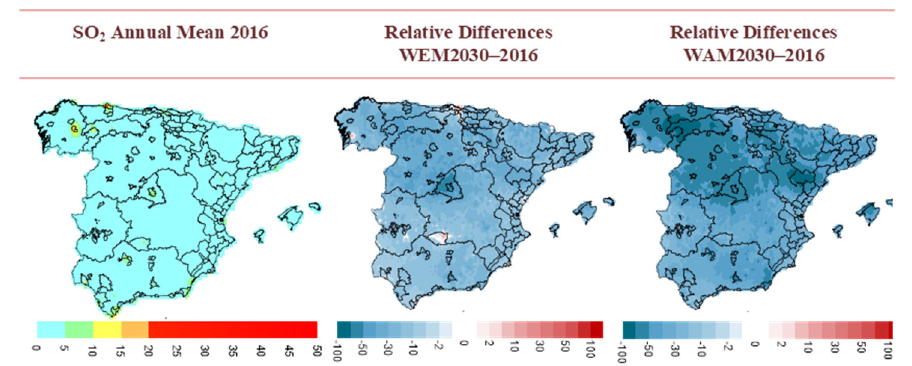
Figure 9. SO 2 annual concentration map for 2016 ( µ g m − 3 ) ( left ) and relative differences (%) with respect to 2016 for the WEM2030 scenario ( middle ) and WAM2030 scenario ( right ).